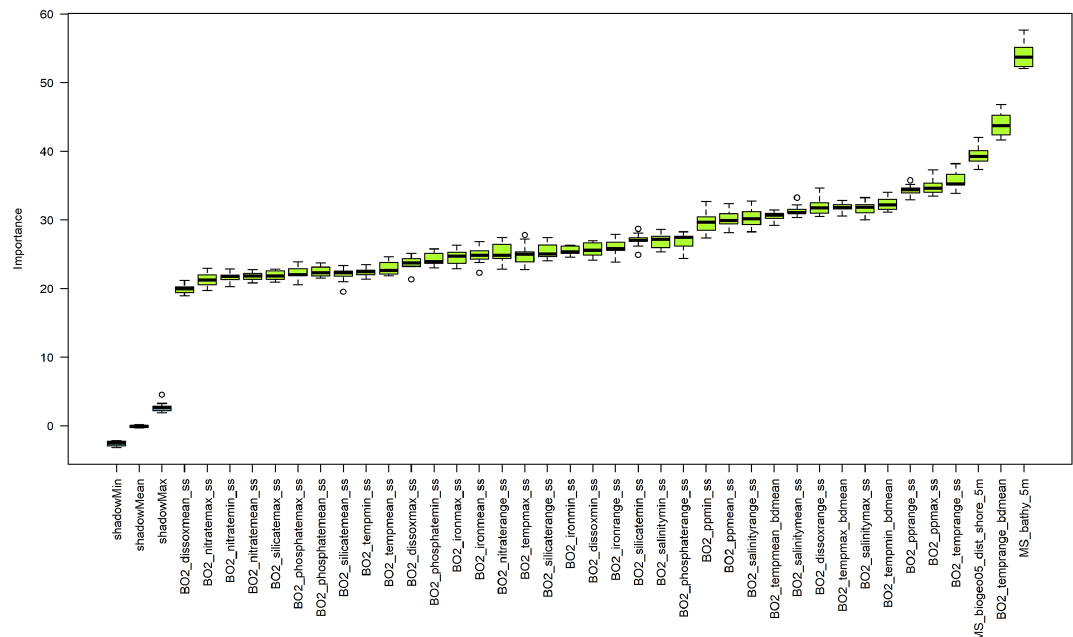
Figure 2. Results of the Boruta variable selection process. All environmental predictor variables had an importance significantly higher than the shadow variables (shadowMin, shadowMean, and shadowMax).